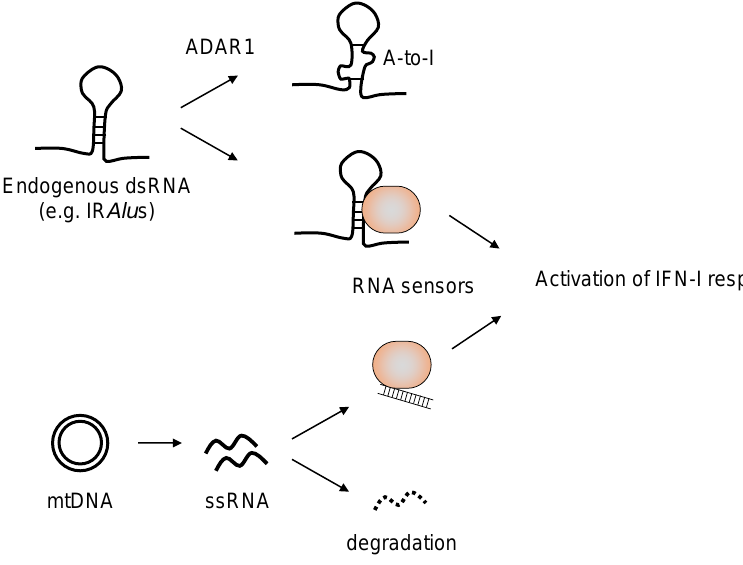
Figure 3. Mechanisms where endogenous RNAs can be recognized by RNA sensors. IRAlu elements can form dsRNA as self. Adenosine deaminase (ADAR) 1 destabilizes dsRNA structures via its A-to-I editing, which results in an escape from the recognition of host RNA sensors. mtDNA also potentially Figure 3. Potential mechanisms by which endogenous RNAs can be recognized by RNA sensors. generates dsRNAs. The degradosome localized to the mitochondria can prevent dsRNA formation by limiting the accumulation of transcripts derived from mtDNA. In both cases, the abnormal formation of dsRNA can lead to aberrant type I IFN (IFN-I) responses. IRAlu; inverted repeat Alu, mtDNA; mitochondrial